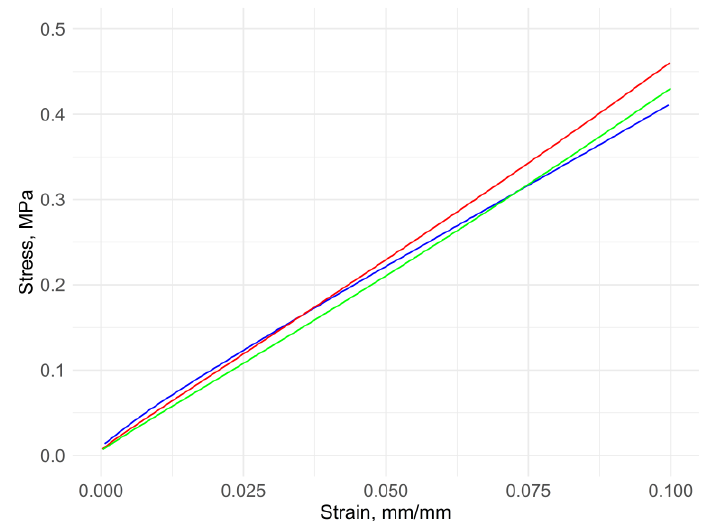
Figure 5. Experimental results for different shape factors: 0.75 (blue), 0.5 (red) and 0.3 (green).